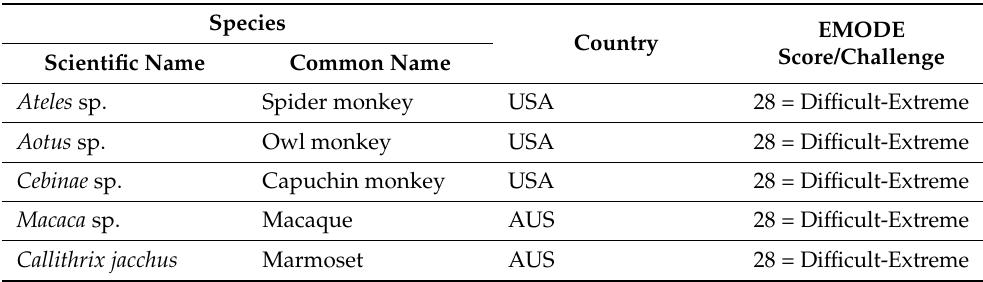
Table 8. Mammals involved in handling and other practices at mobile zoos by species and country of where used, and their EMODE ‘suitability to keep’